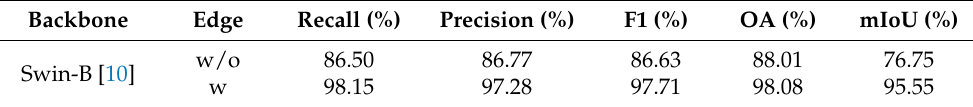
Table 1. The results of extracting the edge from the ground truth. Backbone Edge Recall (%) Precision